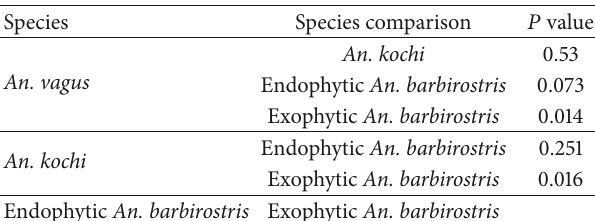
Table 4: MBR comparison between An. vagus, An. kochi , and An. barbirostris